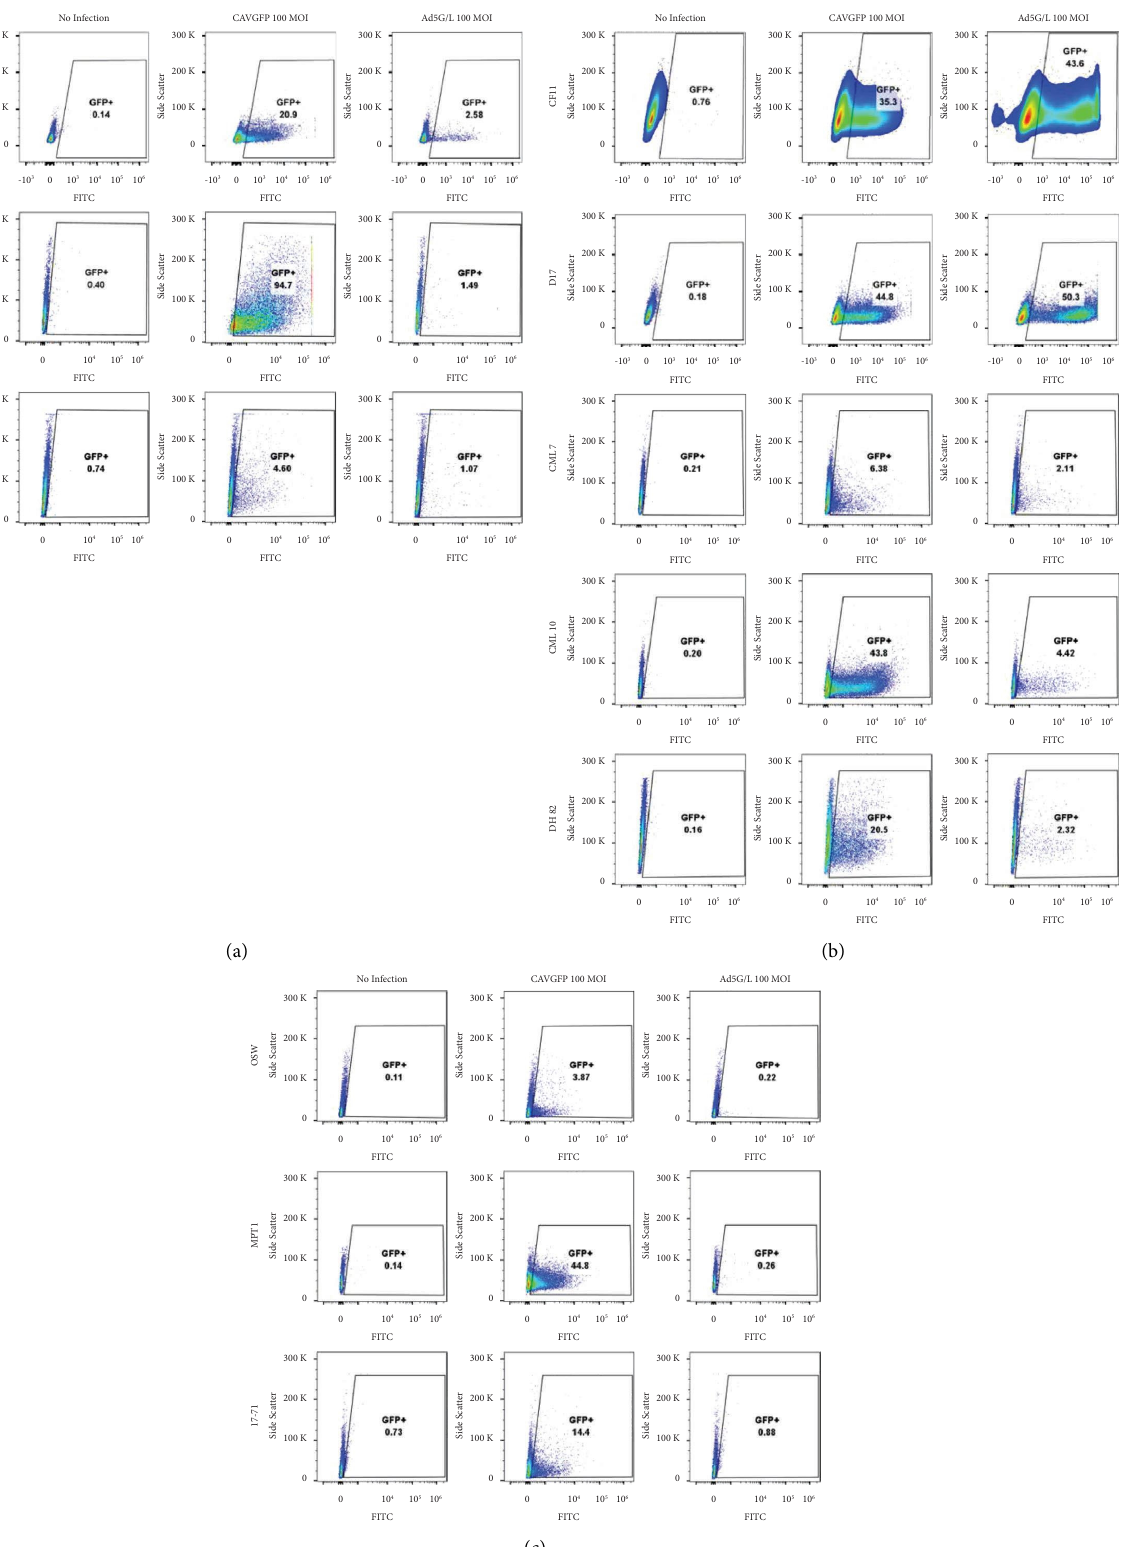
Figure 2: GFP Expression analysis in canine cell lines at 100 MOI by fow cytometry. Cells were transduced by Adenovirus CAV2 and Ad5G/L at 100 multiplicity of infection (MOI 100virus particles per cell). GFP expression in cells was analyzed by fow cytometry 48 hours after Ad5G/L infection. Te cell population was gated for live and single cells. Te GFP+cells were determined in comparison to cell with no adenovirus infection. (a) Adherent cell lines, FDK, MDCK, and CMT12, (b) CF11, D17, CML7, CML10, and DH82, and (c) suspended cell lines, OSW, 17–71, and MPT1. Tis fgure is a representative of three independent infection